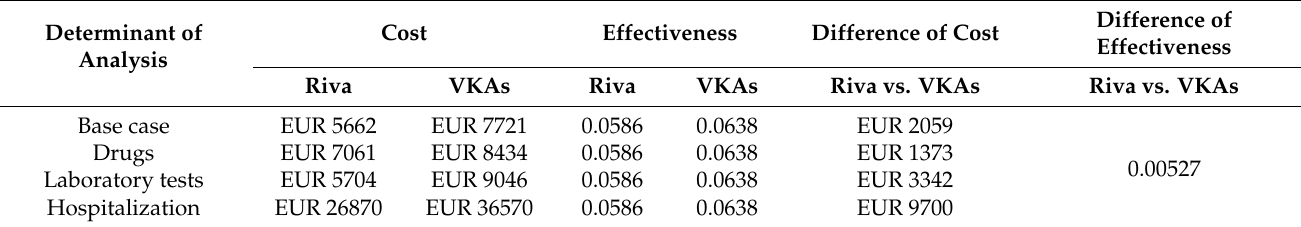
Table 5. Deterministic sensitivity analysis.